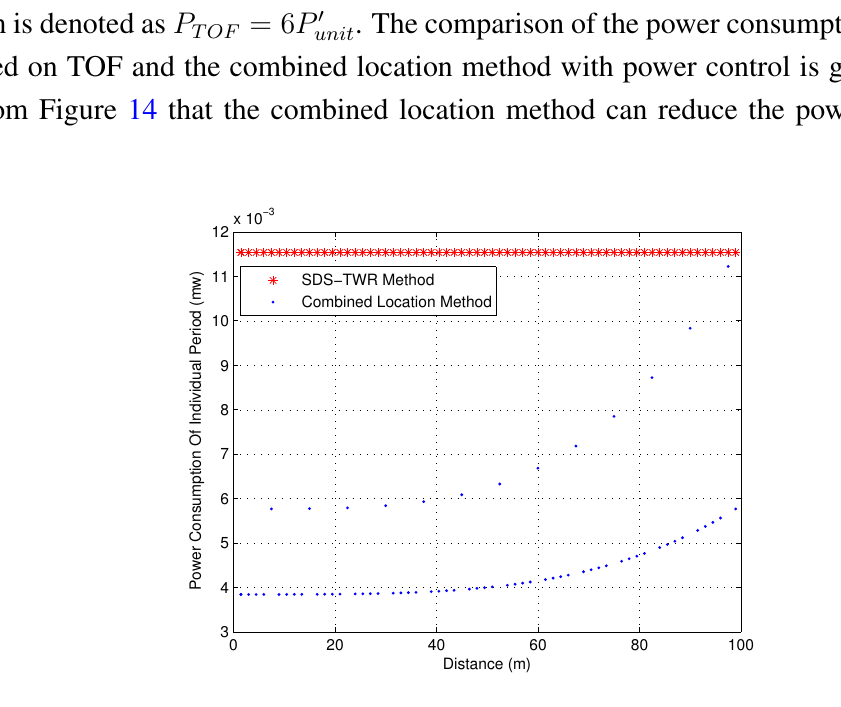
Figure 14. The estimated power consumption of different location